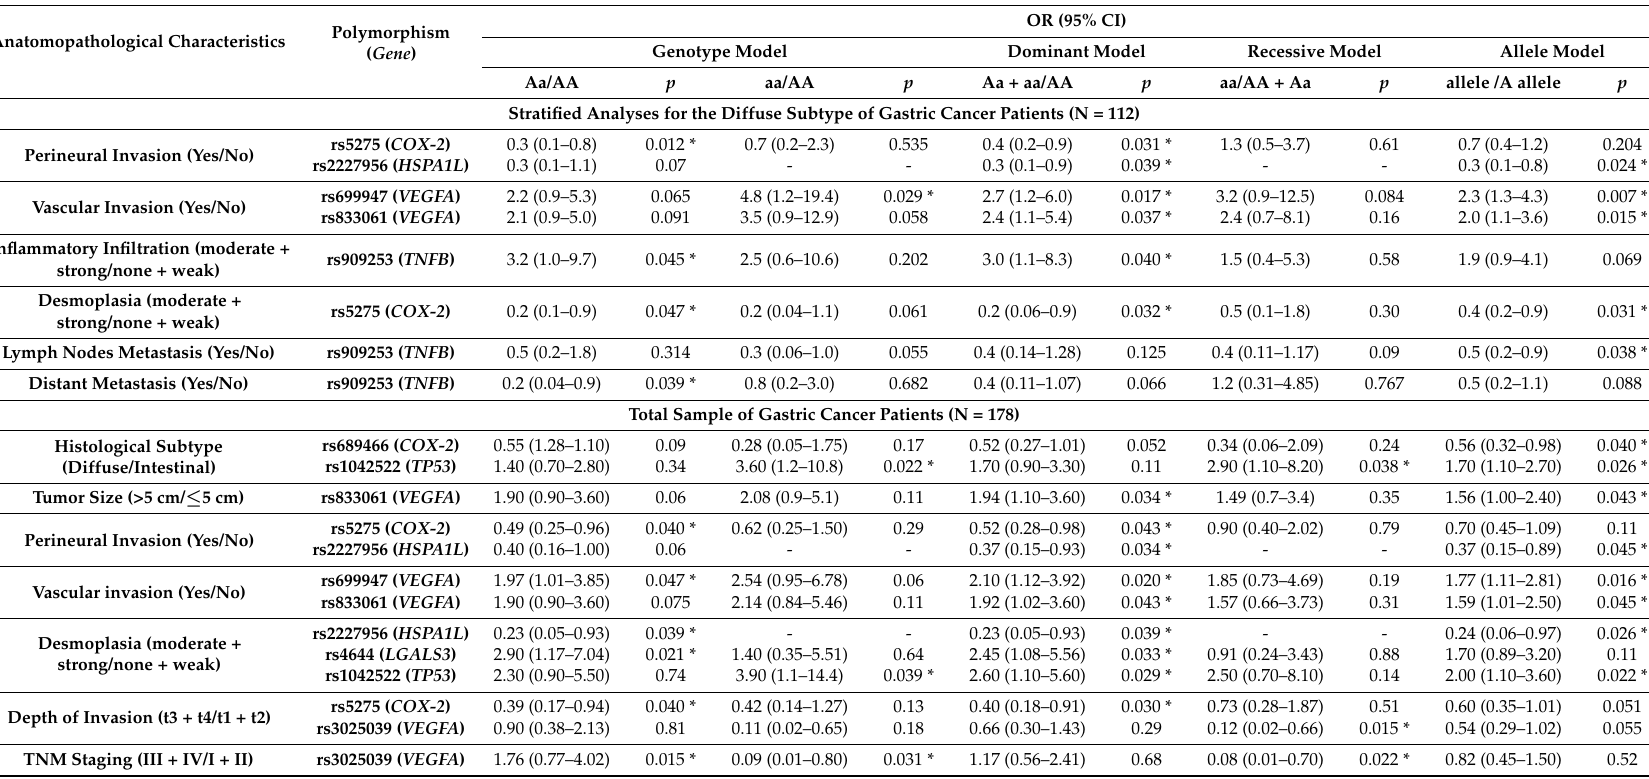
Table 3. Significant associations detected between polymorphisms and anatomopathological features (both in the cases stratified for the diffuse histological subtype and in the total